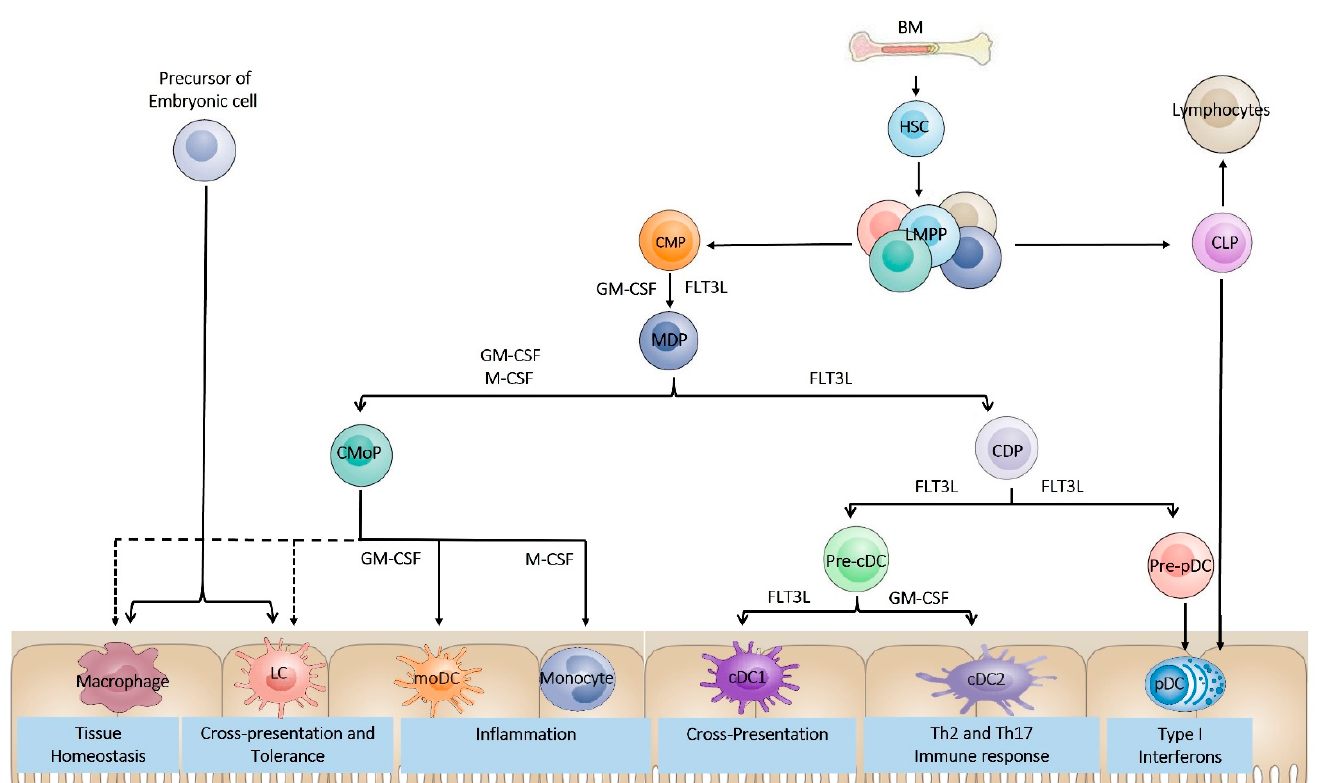
Figure 1. Ontogeny of functionally specialized dendritic cell subsets. Dendritic cells (DCs) originate from hematopoietic stem cells (HSCs) in the bone marrow (BM) that transit into lymphoid-primed multipotent progenitors (LMPPs). LMPPs differentiate into common myeloid progenitors (CMPs) and common lymphoid progenitors (CLPs). CMPs then branch into common DC progenitors (CDPs), which give rise to plasmacytoid DCs (pDCs), a major producer of type I interferons, and conventional DC (cDCs), whose primary function is to prime naïve T cells into common monocyte progenitors (CMoPs), which are committed to the monocyte, macrophage, and Langerhans cell (LC) lineages. CLPs give rise to pDCs and lymphocytes, such as T cells, B cells, and NK cells. A distinct macrophage lineage is derived from embryonic precursors and mainly generates tissue-resident macrophages and Langerhans cells, which can also be replaced over time by bone marrow monocyte-derived macrophages in different tissues, especially under inflammatory conditions. Tissue-resident macrophages maintain tissue homeostasis and are poor inducers of naïve T cells but are potent activators of B cells and are efficient at clearing apoptotic cells. Although LCs are categorized with macrophages on an ontogeny basis, they display many functional activities that overlap with cDCs. Monocyte-derived DCs (MoDCs), also known as inflammatory DCs (iDCs), are potent producers of TNF/iNOS (TIP) and are prominent at the site of inflammation. They typically execute functions in the tissues, such as antigen presentation to T effector cells, eradication of pathogens, and cytokine production. Stages at which key growth factors have been determined to be essential are indicated. MDP, macrophage and DC progenitor; Pre-pDC, pre-plasmacytoid DC; Pre-cDC, pre-conventional DC; cDC1, conventional type I DC; cDC2, conventional type II DC; GM-CSF, granulocyte-macrophage colony-stimulating factor; M-CSF, macrophage colony-stimulating factor; FLT3-L, Fms-like tyrosine kinase 3 ligand.